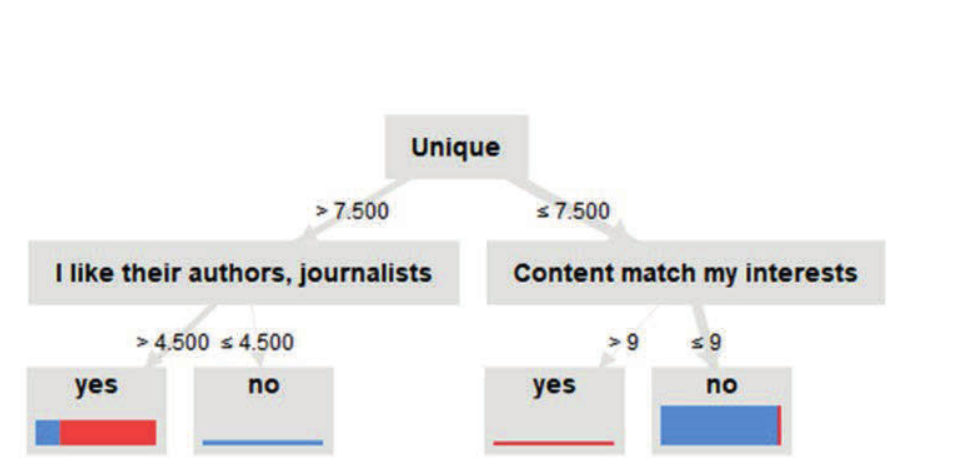
Fig. 2. Tv3.lv brand uniqueness impact on tv3.lv brand equity, decision tree test, RapidMiner